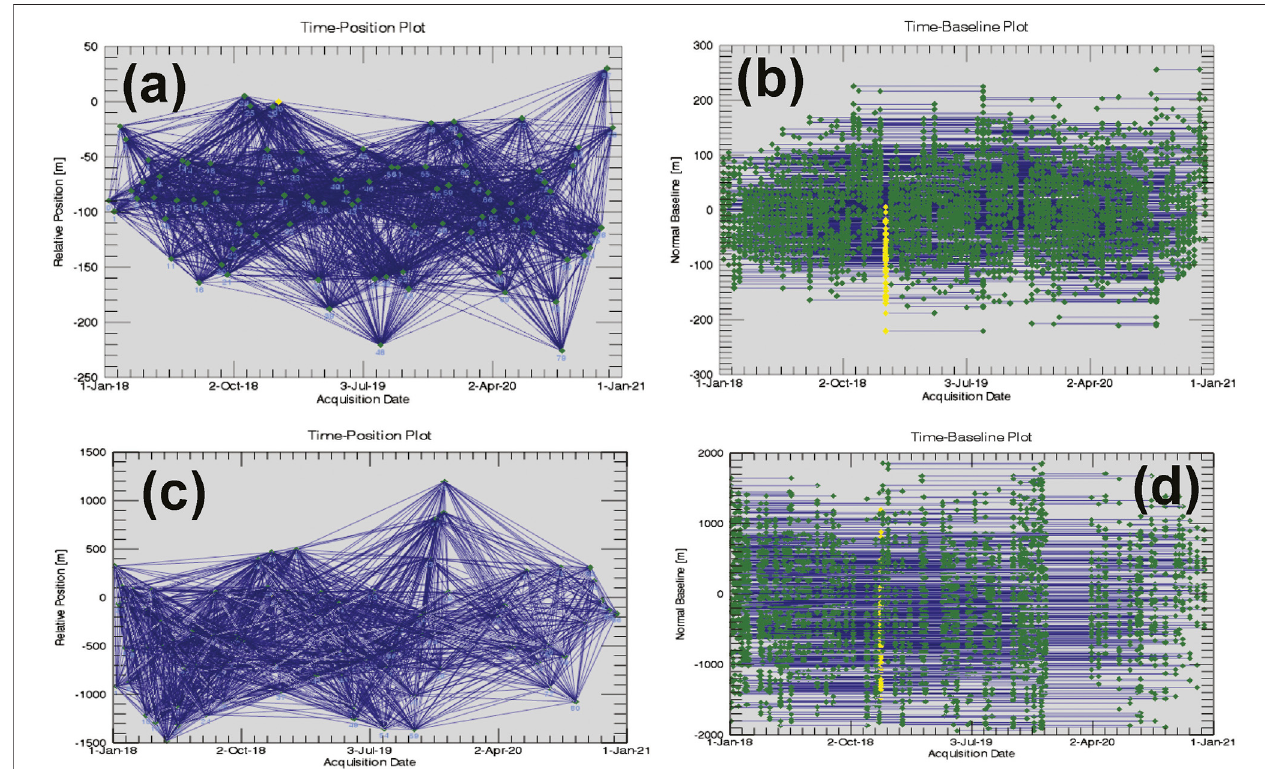
FIGURE3|(A) Sentinel-1time-positionplotforSBAS; (B) Sentinel-1time-baselineplotforSBAS; (C) COSMO-SkyMedtime-position plotforSBAS; (D) COSMO- SkyMed time-baseline plot for